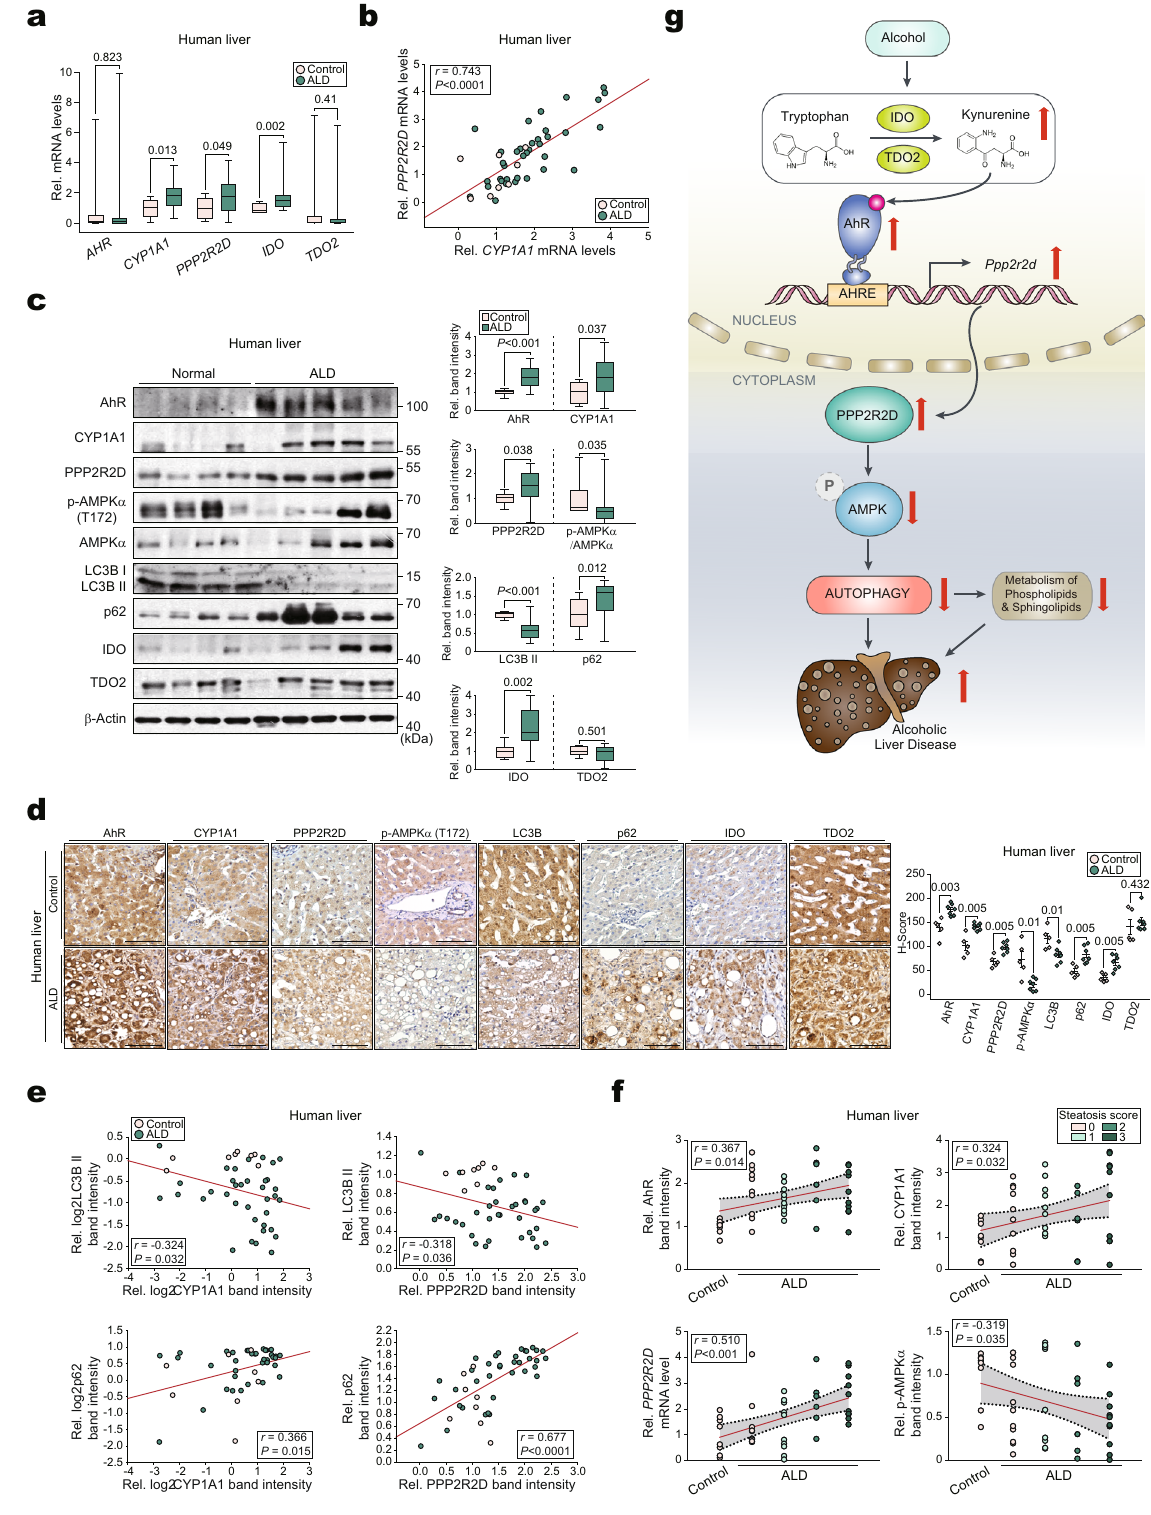
molecules, and free fatty acids, followed by fl ow injection analysis tandem mass spectrometry (FIA-MS/MS) of 12 lipid classes and hexo- ses, using a 5500 QTRAP® instrument. Brie fl y, a 96-well-based sample preparation device was used to quantitatively analyze the metabolite pro fi le in the samples. This device consists of inserts that have been spotted with internal standards, and a prede fi ned sample amount was added to the inserts. Next, a phenylisothiocyanate solution was